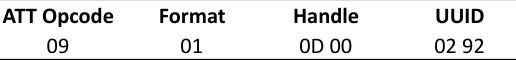
Figure 8. Descriptor discovery